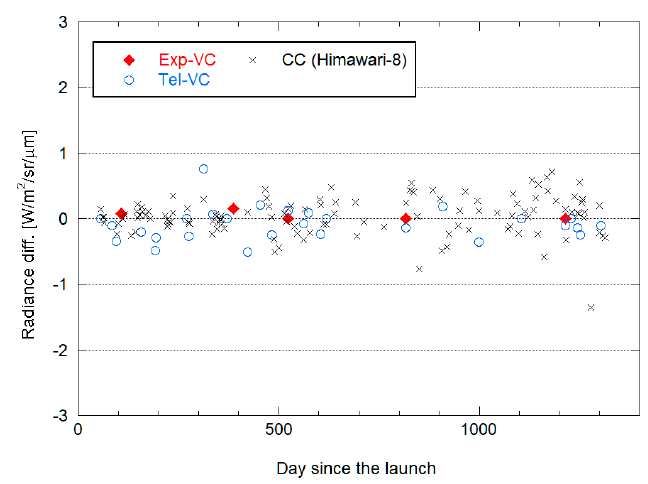
Figure20. Di ff erencebetweentherecalibratedradiance( R x )andthepredictedradianceforCALET / CIRC Figure 20. Difference between the recalibrated radiance ( R x ) and the predicted radiance for as a function of the day since the launch ( D ). CALET/CIRC as a function of the day since the launch ( D ). Table 4. Number of data used, RMS di ff erence in radiance, and that in temperature at 300 K for Table 4. Number of data used, RMS difference in radiance, and that in temperature at 300 K for the